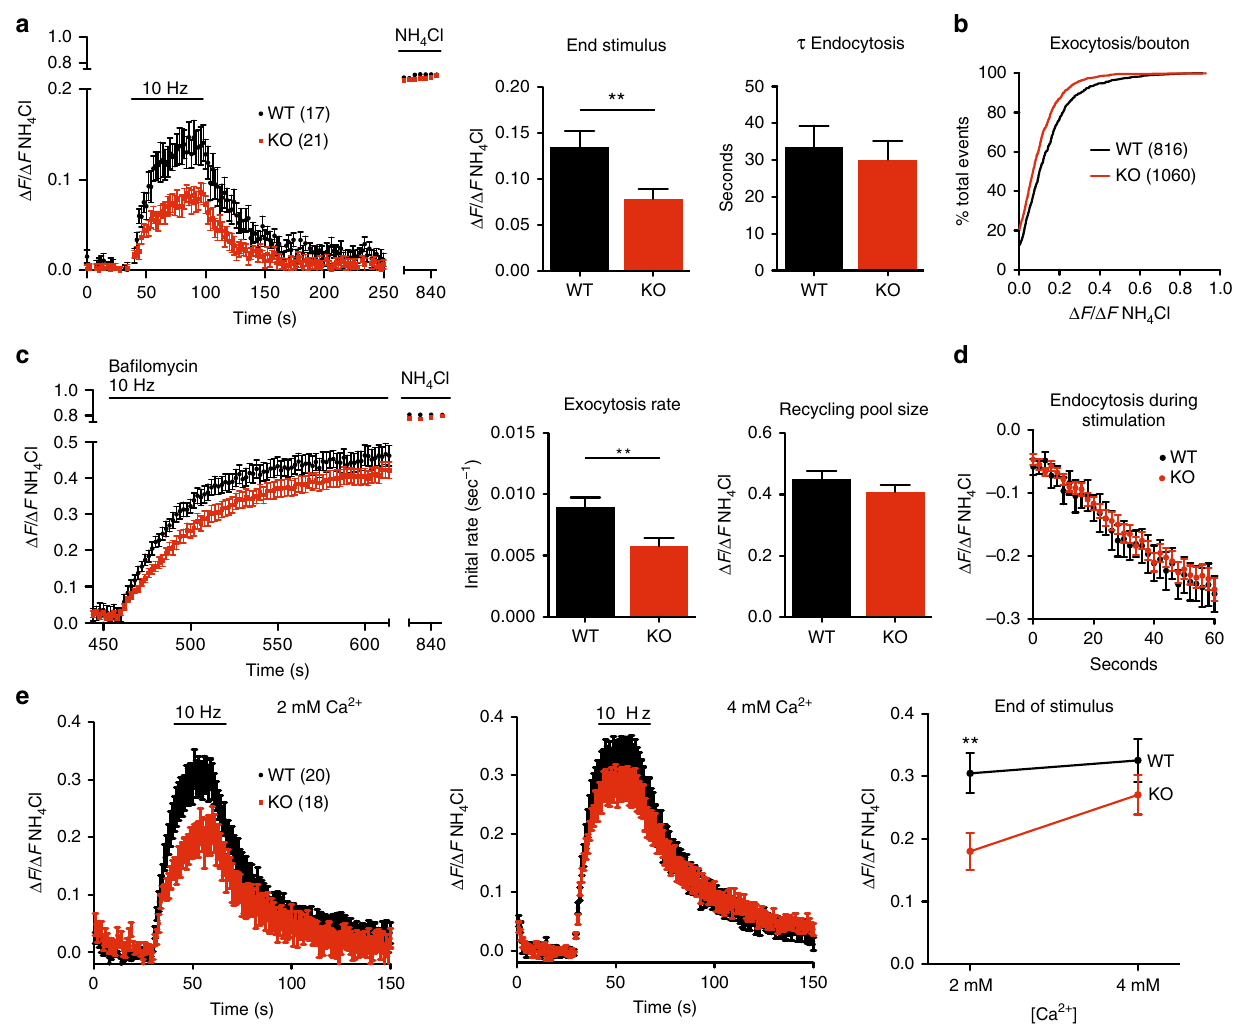
Fig. 5 Loss of NHE9 impairs synaptic vesicle exocytosis. a Cultured hippocampal neurons from NHE9 KO mice show a smaller VGLUT1-pHluorin fl uorescence response than WT cells to 10 Hz stimulation for 60 s (left panel). Middle panel indicates fl uorescence at the end of stimulation. ** p < 0.01 by unpaired Student ’ s t test. Right panel shows no change in the time constant of endocytosis ( τ ), p = 0.65. b Cumulative frequency distribution of the extent of exocytosis for all boutons shows a consistent shift to smaller values for the NHE9 KO relative to WT. p < 0.0001 by Kolmogorov – Smirnov. WT, n = 816 boutons; KO, n = 1060. c Hippocampal neurons expressing VGLUT1-pHluorin were stimulated at 10 Hz for 60 s, then stimulated again at 10 Hz for 150 s in the presence of ba fi lomycin. The fl uorescence change in the presence of ba fi lomycin (left) was used to determine the initial rate of exocytosis (middle), which is reduced for NHE9 KO neurons relative to WT, p = 0.0047. The recycling pool size, determined by normalizing the peak fl uorescence response in ba fi lomycin to the total fl uorescence revealed in NH 4 Cl (right), shows no change ( p = 0.22). d The rate constant of endocytosis during stimulation was calculated by subtracting the fl uorescence in the presence of ba fi lomycin from that in the absence. NHE9 KO neurons do not differ from WT in endocytosis during or after the stimulus. n = 17 (WT) or 21 (KO) coverslips/genotype for c and d . Bar graphs indicate mean ± s.e.m. e Response of VGLUT1-pHluorin to 10 Hz stimulation shows that 4 mM Ca 2+ rescues the exocytosis defect in the NHE9 KO neurons observed at 2 mM Ca 2+ , ** p < 0.01 by two-tailed unpaired t test. N = 20 WT, 18 KO